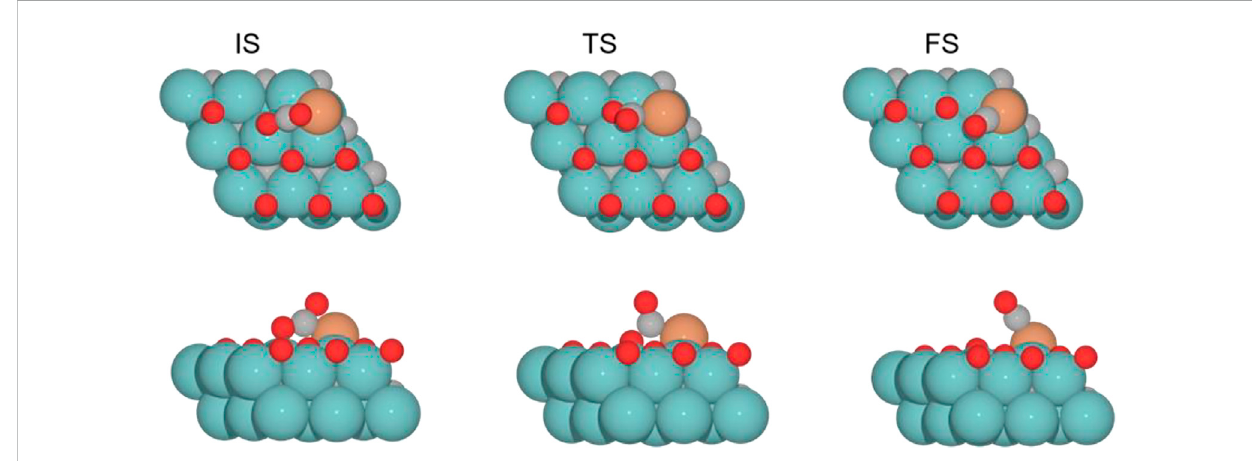
FIGURE 5 Top and side views of the initial state (IS), transition state (TS), and fi nal state (FS) for the CO 2 cleavage catalyzed by the Fe/Mo 2 C of 0.78 ML system (see Supplementary Figures S1 – S3 for the structures of other intermediates and TS on 0, 0.33, and 0.67 O* ML coverages).